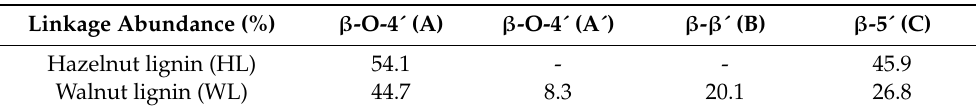
Table 4. Relative abundance of the main inter-unit linkages from the integration of 13 C- 1 H correlation signals in the HSQC spectra.